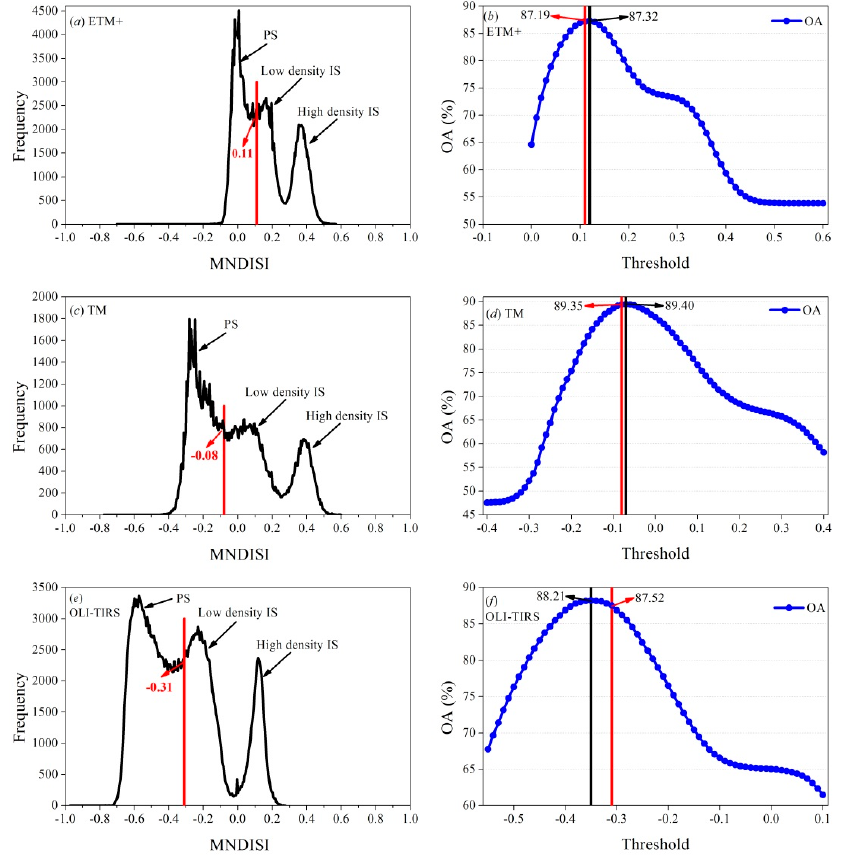
Figure 6. The MNDISI histograms and the overall accuracy (OA) curves for summer images of: ETM+ ( a , b ); TM ( c , d ); and OLI ( e , f ). Their optimal thresholds are marked in each histogram, and the OA value using this threshold (red line) is positioned in the corresponding OA curve. The black line represents the threshold reaching the highest accuracy of ISA mapping.